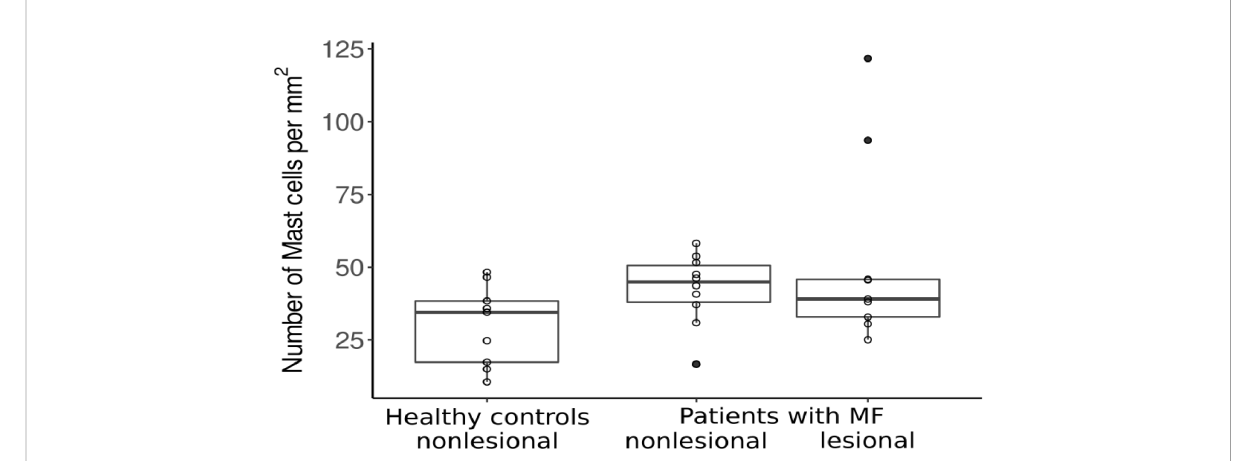
FIGURE 1 Mast cell counts in the papillary dermis of healthy patients and patients with MF. MF, Mycosis